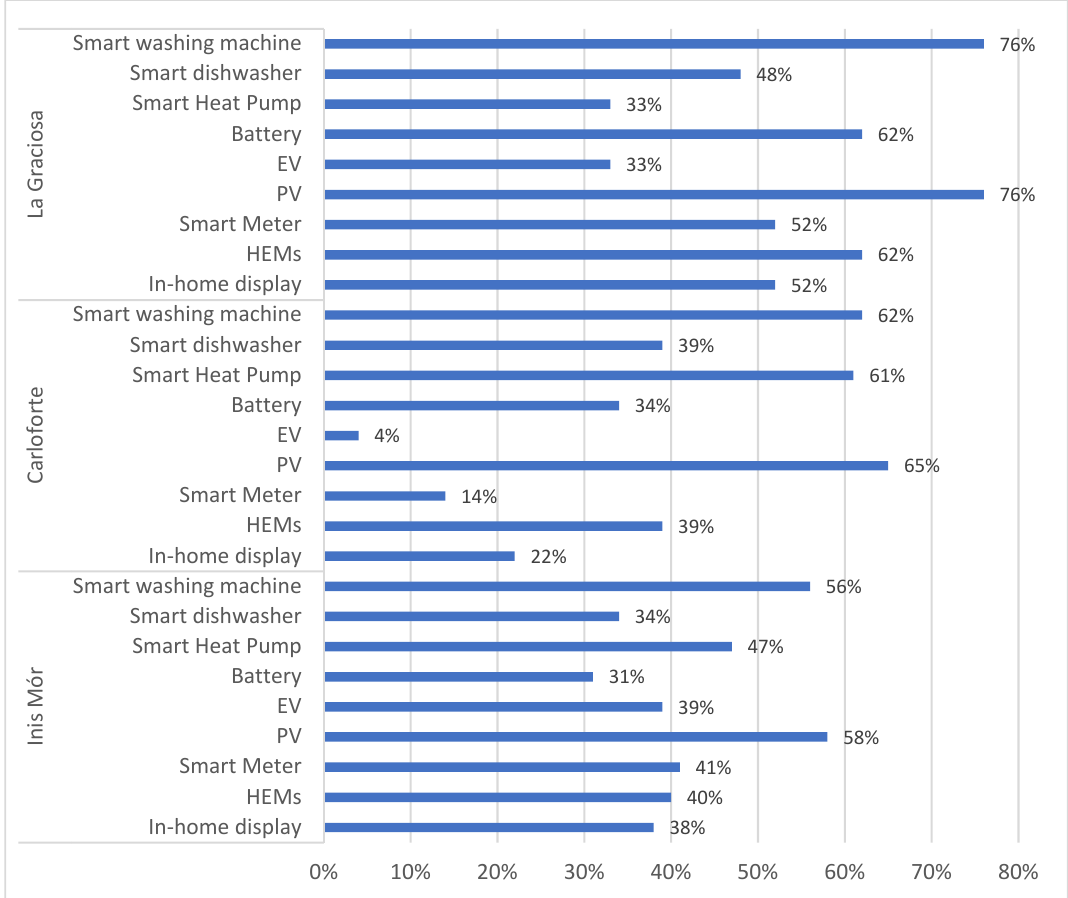
Figure 7. Willingness of island respondents to use SG enabling technologies.